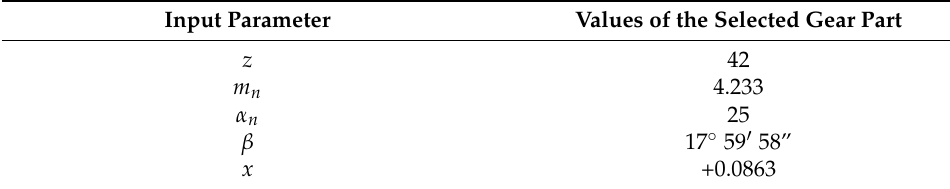
Table 4. Input-independent design parameters of the selected gear.